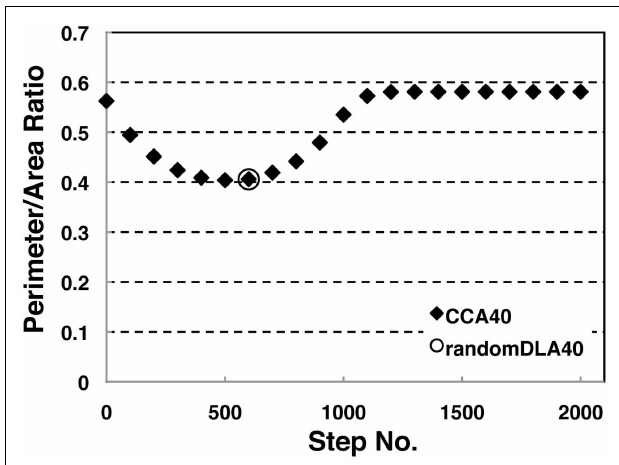
FIGURE 5 | Perimeter-area ratio of random DLA (40%) and CCA 40 models. The x -axis shows a step number to build CCA models, and the y -axis shows the value of a ratio between the perimeter of whole NRO clusters and the sum of the area occupied by NRO.The bottom value appeared at CCA 40 , s500 ( =